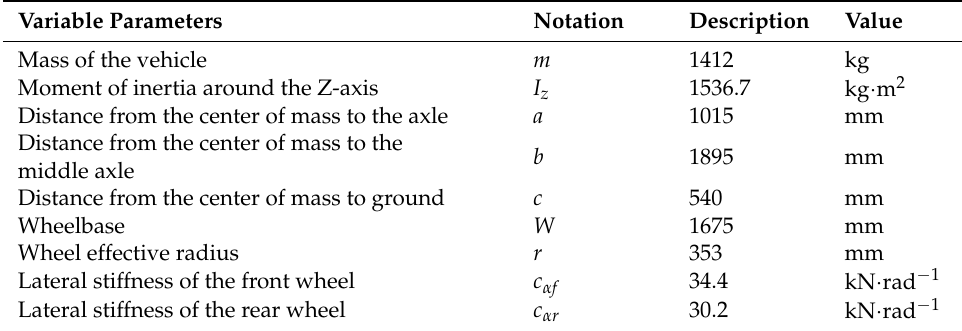
Table 4. Main parameters of the 4WID vehicle.